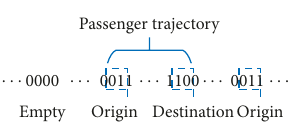
Figure 2: Description of passenger trajectory data of taxis.